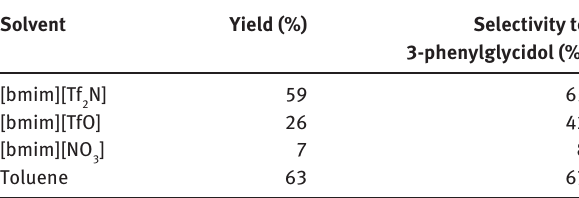
Table 1 Selectivity 1 (%) of the epoxidation reaction of cinnamyl alcohol in different ILs [3 mol% of VO(acac) 2 h]. 1 Selectivity is defined as the molar ratio of desired product to the total amount of